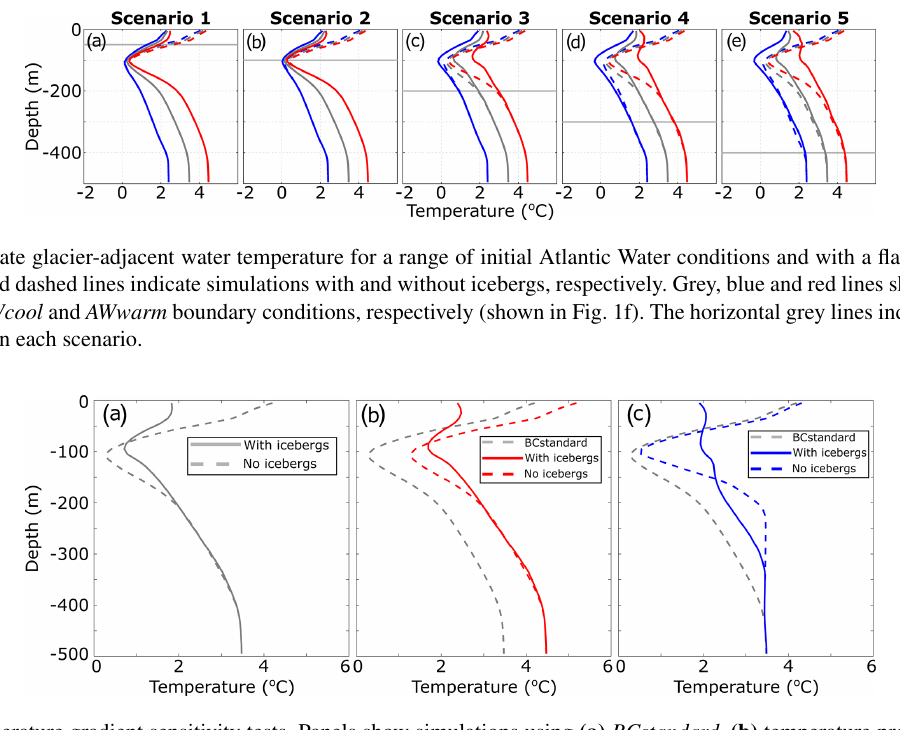
Figure 7. AW temperature gradient sensitivity tests. Panels show simulations using (a) BCstandard , (b) temperature profile shifted by 1 ◦ C throughout the water column, and (c) uniform initial AW temperature of 3.5 ◦ C. Steady-state conditions without icebergs using BCstandard (grey line) are also shown in (b) and (c) for